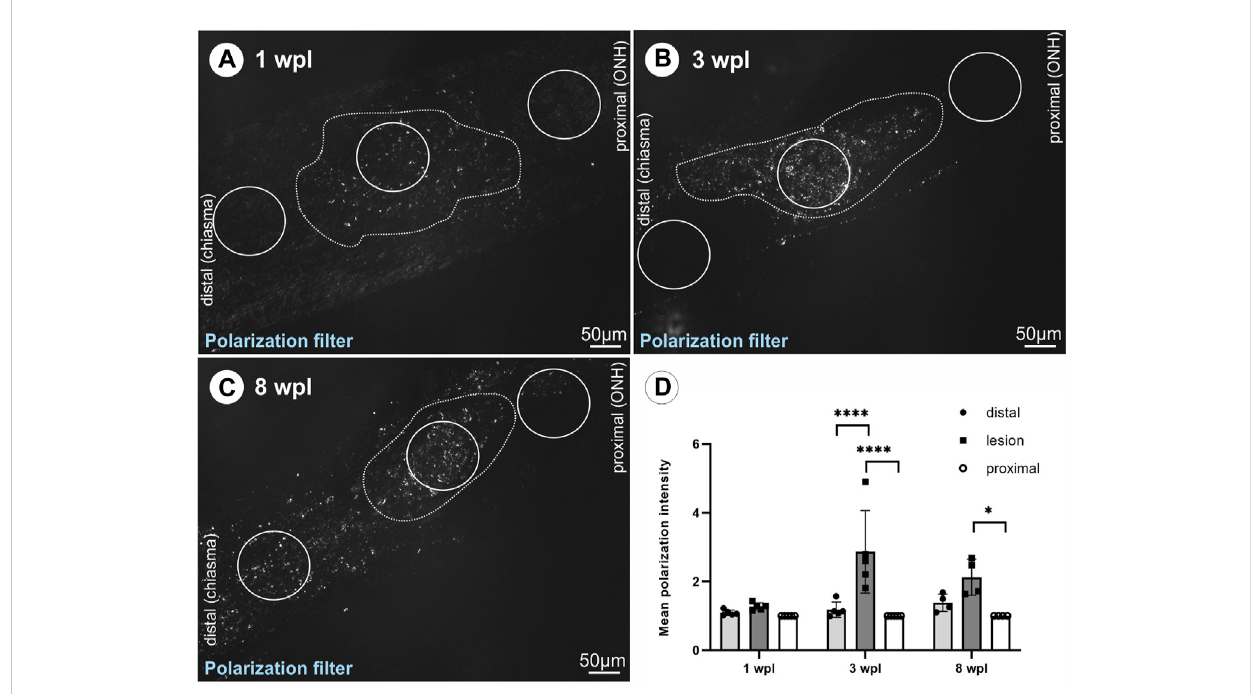
FIGURE 6 Detection of collagen deposition via polarization signal in the lesioned ON. The polarization signal within the lesioned area versus distal or proximal areas of the ON tissue is shown for (A) 1 wpl ( n = 5), (B) 3 wpl ( n = 5), and (C) 8 wpl ( n = 4). (D) Graph showing mean polarization intensity comparing lesioned,distal,andproximalONtissueat1wpl,3wpl,and8wpl.Thedottedlinehighlightsthehypercellularlesionedarea.Signi fi cancewascalculatedby two-way ANOVA and Š ìdàk ’ s multiple-comparison test; * p < 0.05 and *** p <